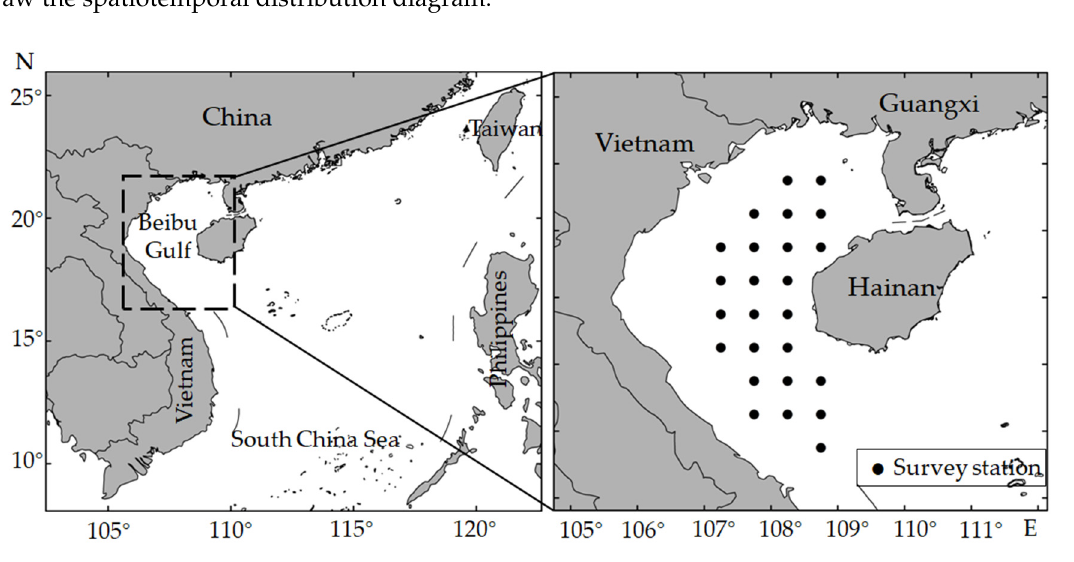
Figure 1. Research area and survey